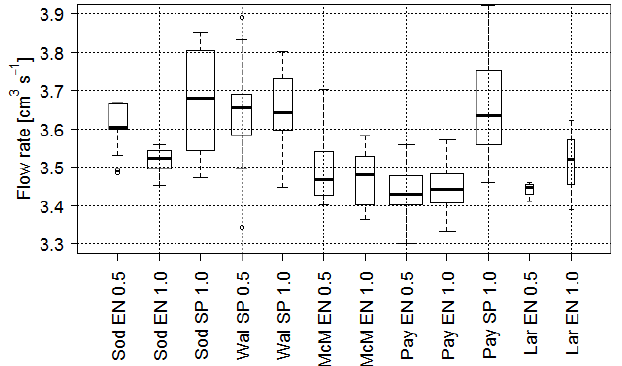
Figure 2. Ozonesonde pump flow rates (cm 3 s − 1 ) measured at the different stations, following the nomenclature of Fig. 1 for the sta- tion and